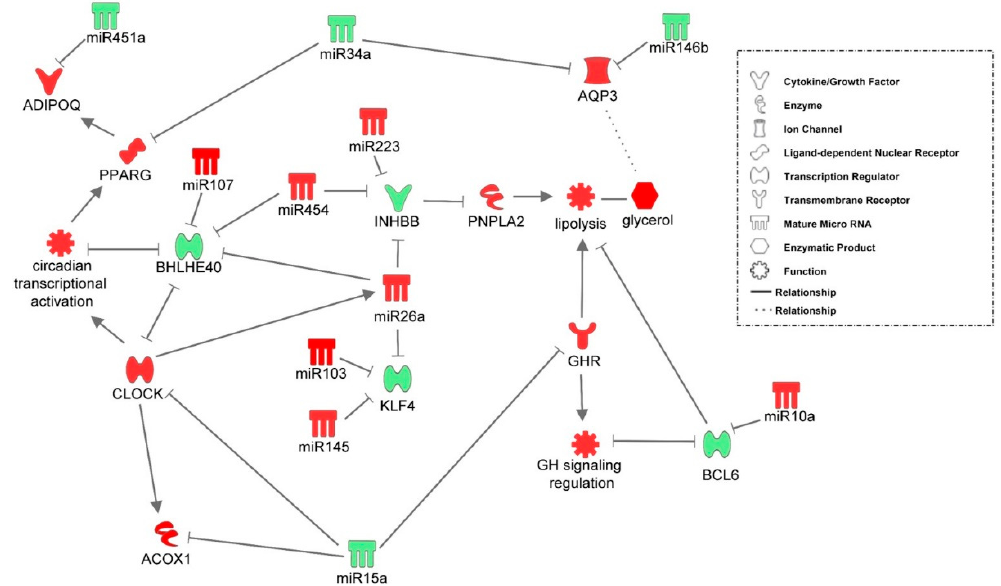
Figure 8. An adipocytic transcriptional and post-transcriptional regulatory system identified in chicks during the embryonic-hatch transition. A complex network of transcriptional regulators and miRNAs likely work in concert to control adipogenic and lipolytic processes during the shift from embryonic metabolism to the post-hatching metabolism. Red molecules have higher expression in D3 adipose tissue than E18 adipose tissue and green molecules have lower expression. Gears represent biological processes and their expected expression pattern is based on the expression signatures of the genes controlling them.